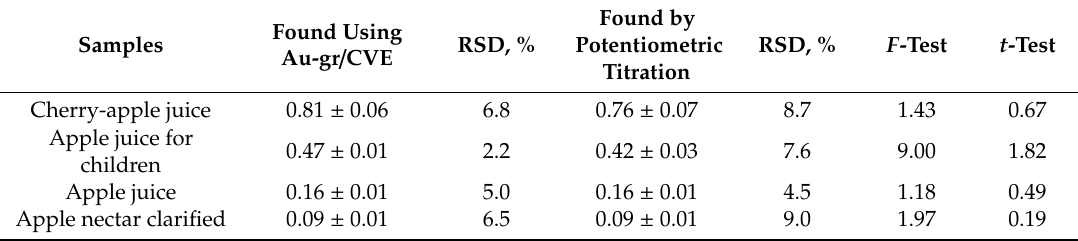
Table 5. Results of AA determination on the proposed Au-gr / CVE sensor and potentiometric titration in fruit juices (n = 3, P =